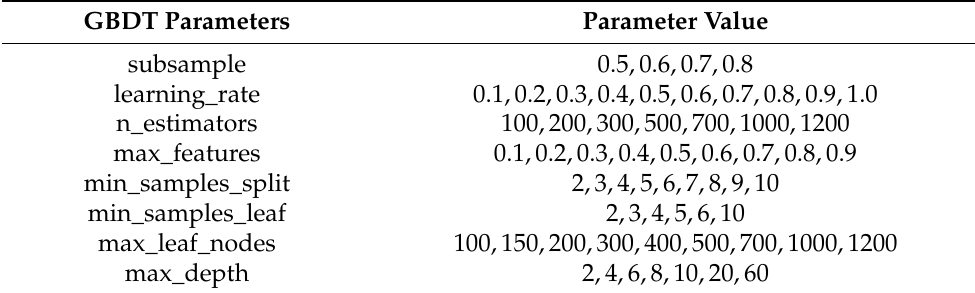
Table 2. Common parameter settings for gradient boosting decision tree